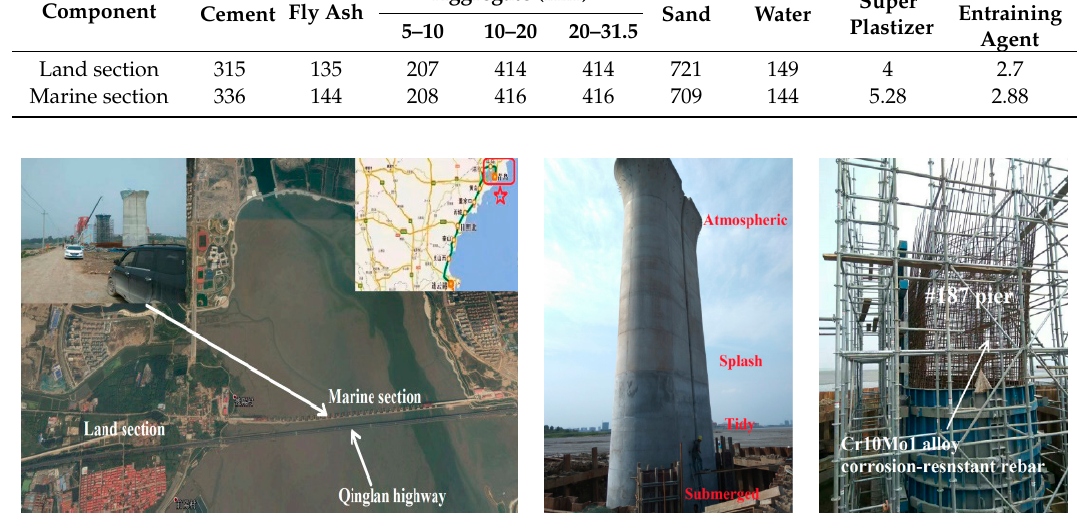
Figure 1. Reinforced concrete pier of the Jiaozhou Bay sea-crossing railway bridge (marine section).